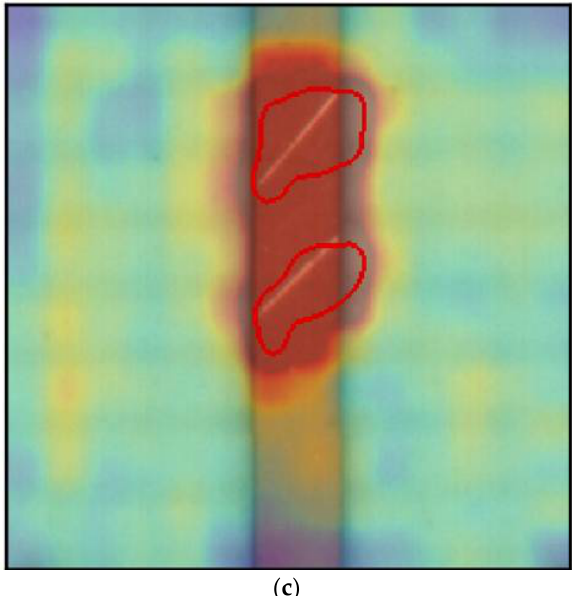
Figure 2. True positive PCB example. ( a ) True positive example 1; ( b ) True positive example 2; ( c ) True positive example 3.